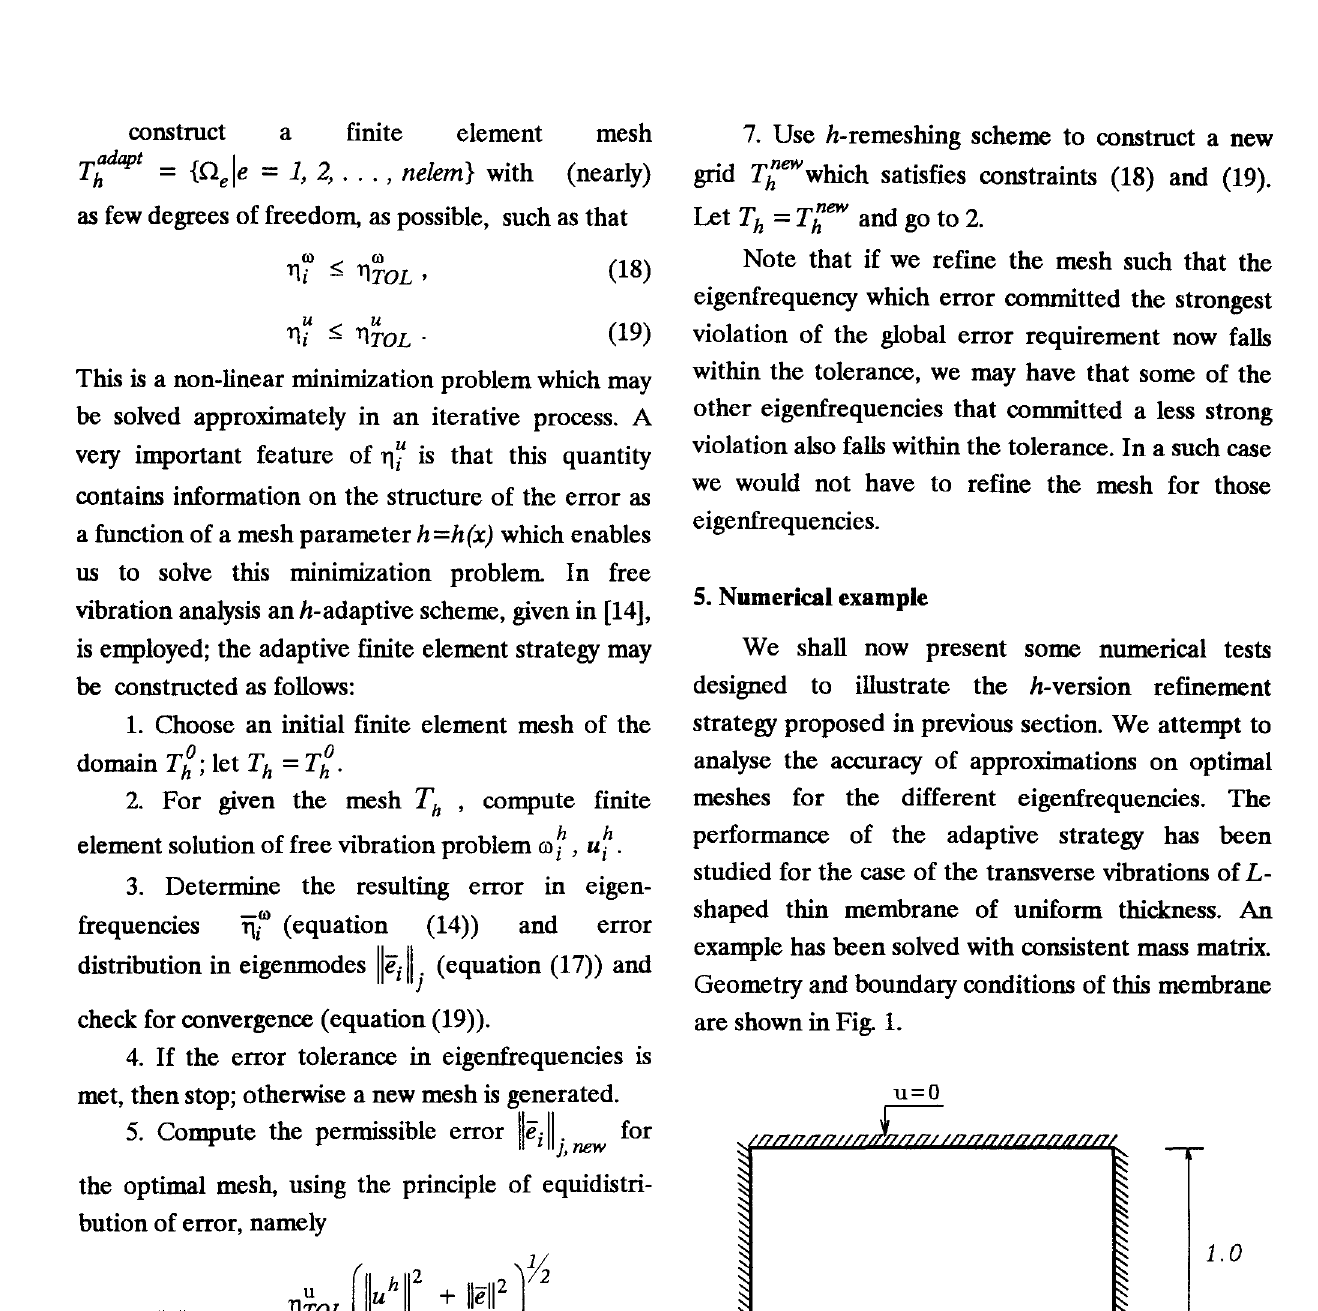
Fig. 1. Geometry and boundary conditions of